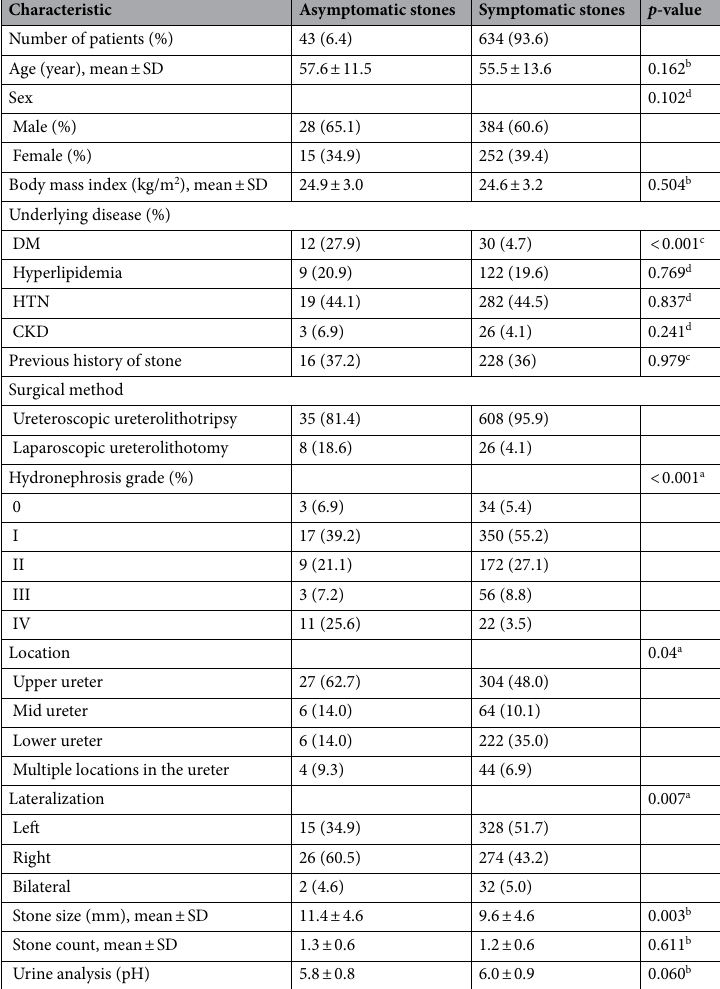
Table 2. Patient characteristics. SD standard deviation, DM diabetes mellitus, HTN hypertension, CKD chronic kidney disease. a Chi-square test. b Independent t -test. c Chi-square test. d Fisher’s exact test.